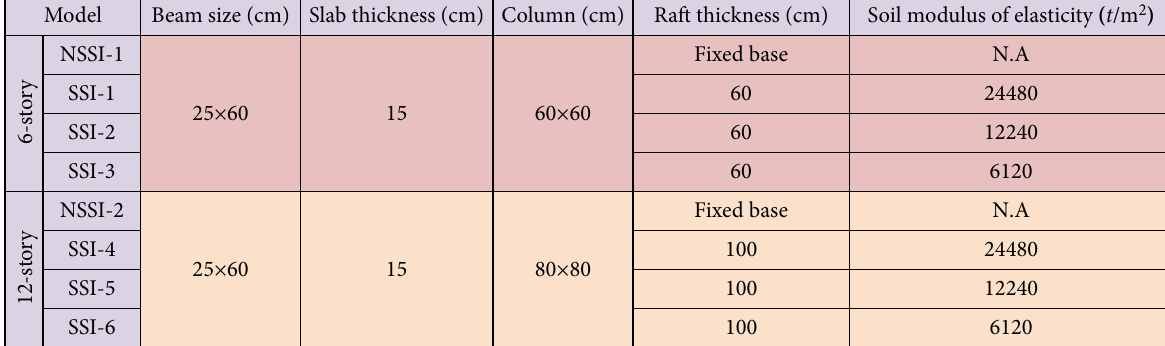
Table 3. Building structural element dimensions for different modulus of elasticity of soil models